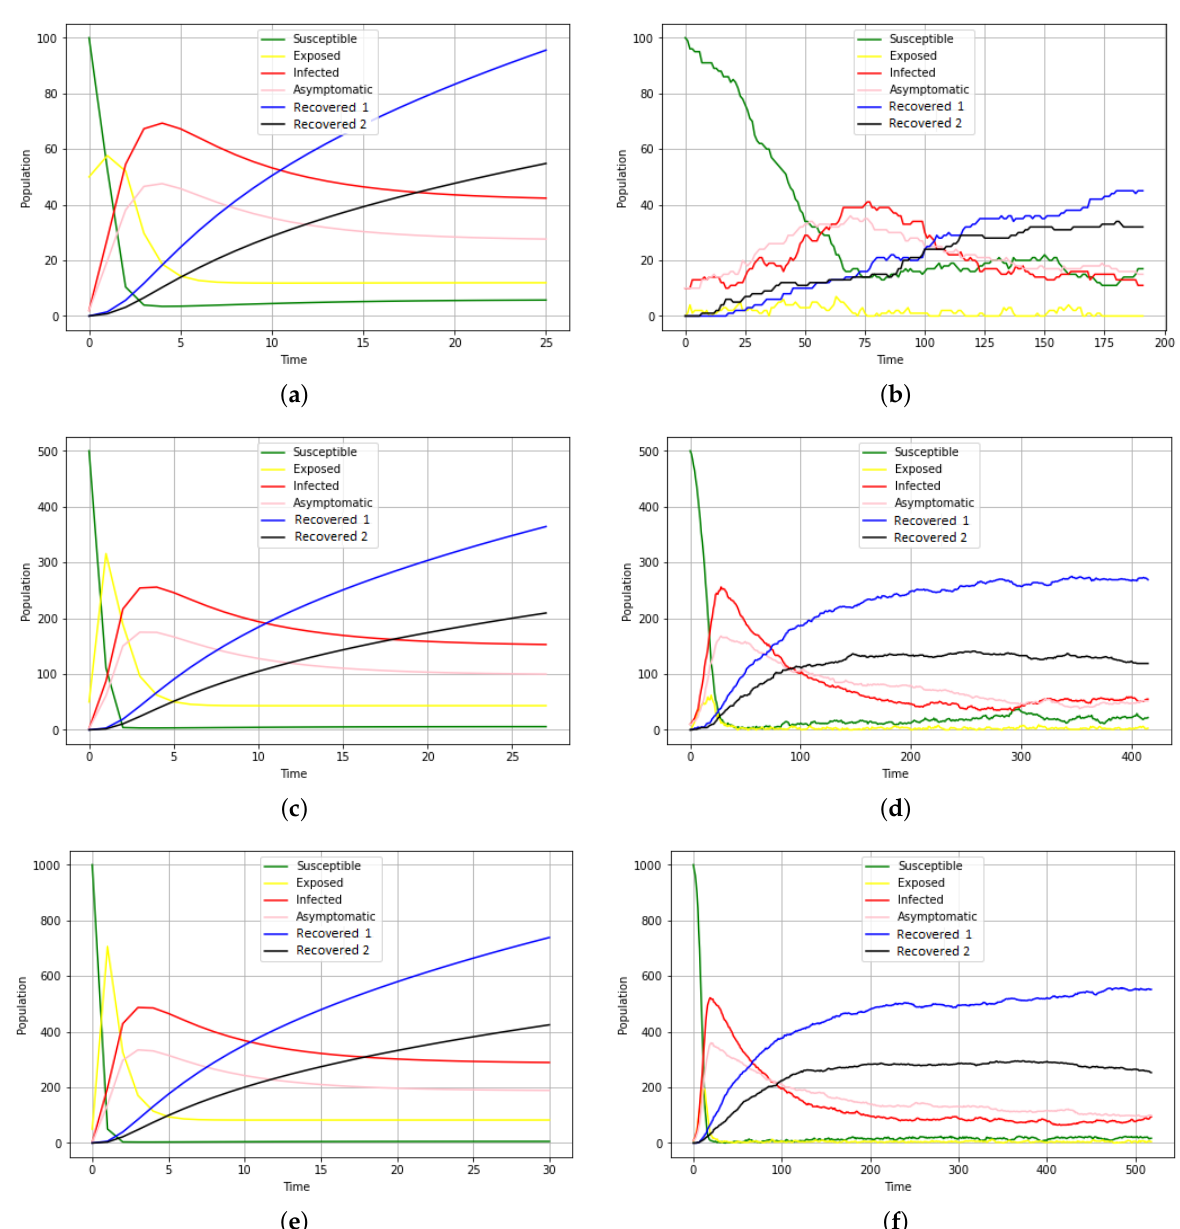
Figure 12. Comparative curves for the two models with: ( a ): the EBM for S = 100; ( b ): the ABM for S = 100; ( c ): the EBM for S = 500; ( d ): the ABM for S = 500; ( e ): the EBM for S = 1000; ( f ): the ABM for S =